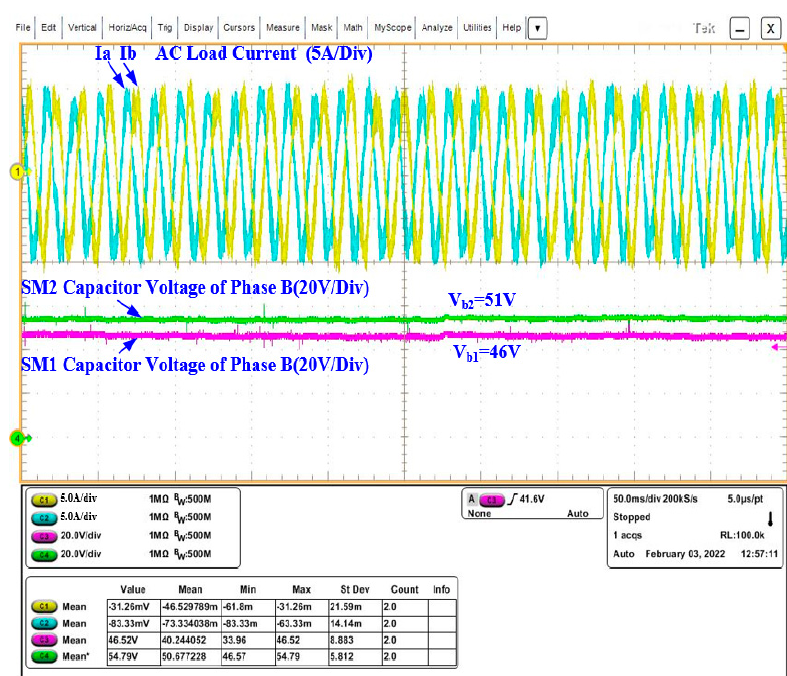
Figure 15. AC current and SM capacitor voltage at 100 V DC link.